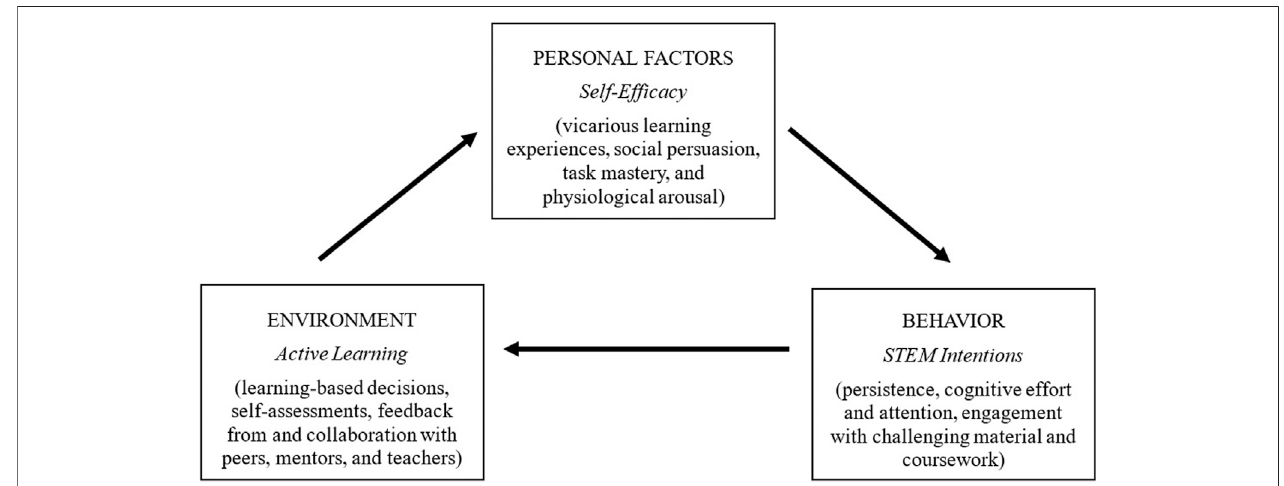
FIGURE 1 | Bandura (1978) model of triadic reciprocality applied to STEM environments, personal factors, and STEM